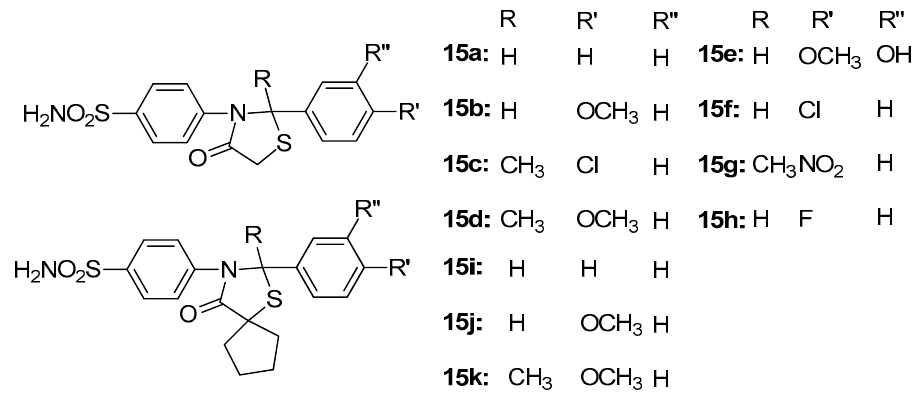
Figure 17. Chemical structures ofthiazolidine-4-one derivatives 15a – h .